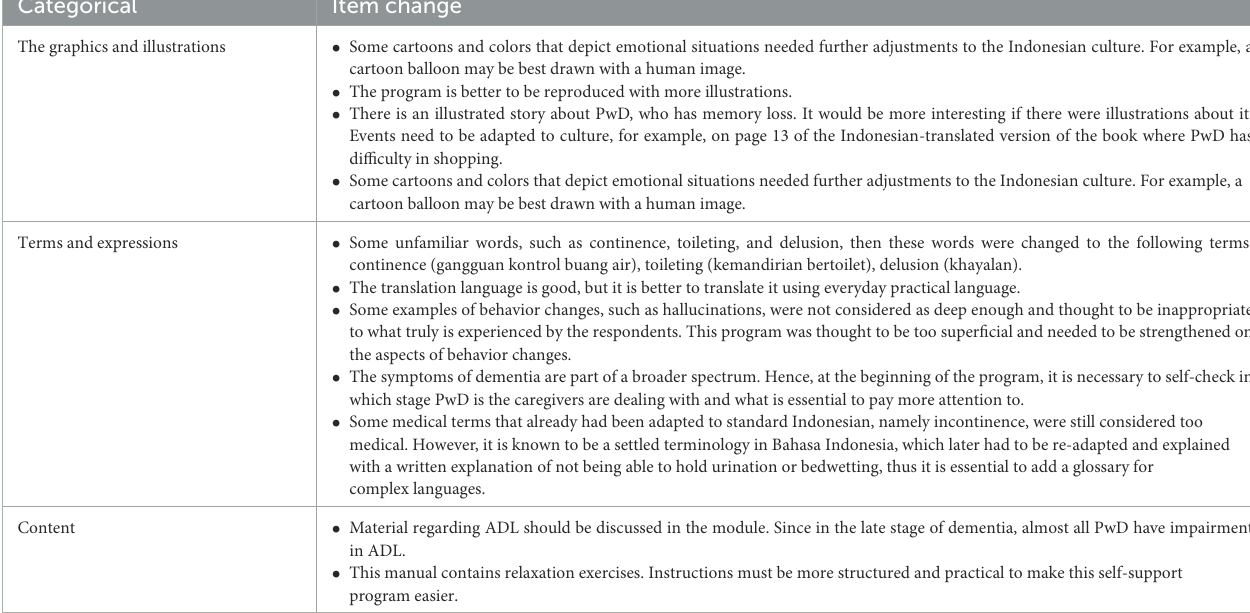
TABLE 3 Adjusting for cultural